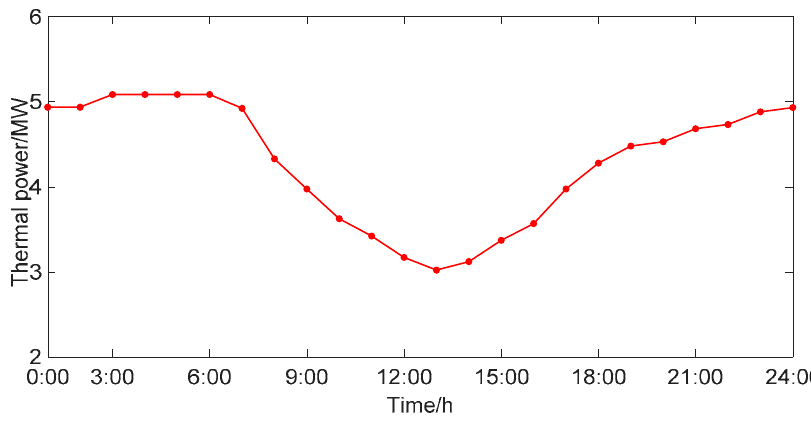
Figure 7. Thermal demand curve of users.